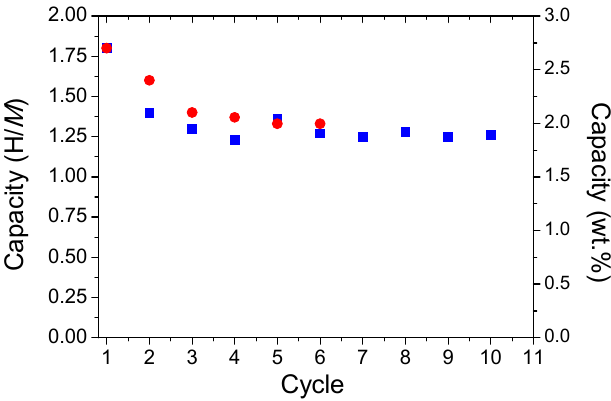
Figure 8. The evolution of the capacity during cycling under different conditions: absorption under 1 bar (circles) and 40 bar H 2 pressure (squares) at room temperature and desorption under vacuum at 400 °C.